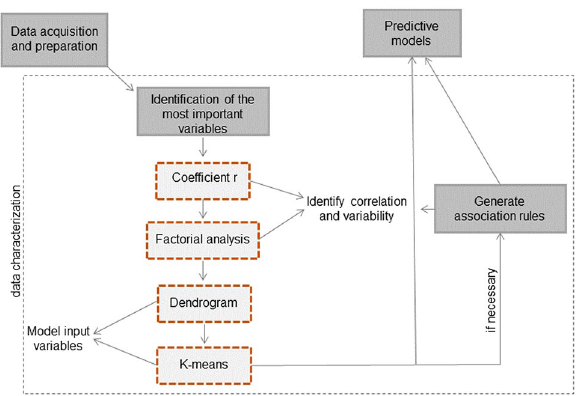
Figure 1. Sequential diagram of the proposed data approach for public health management.